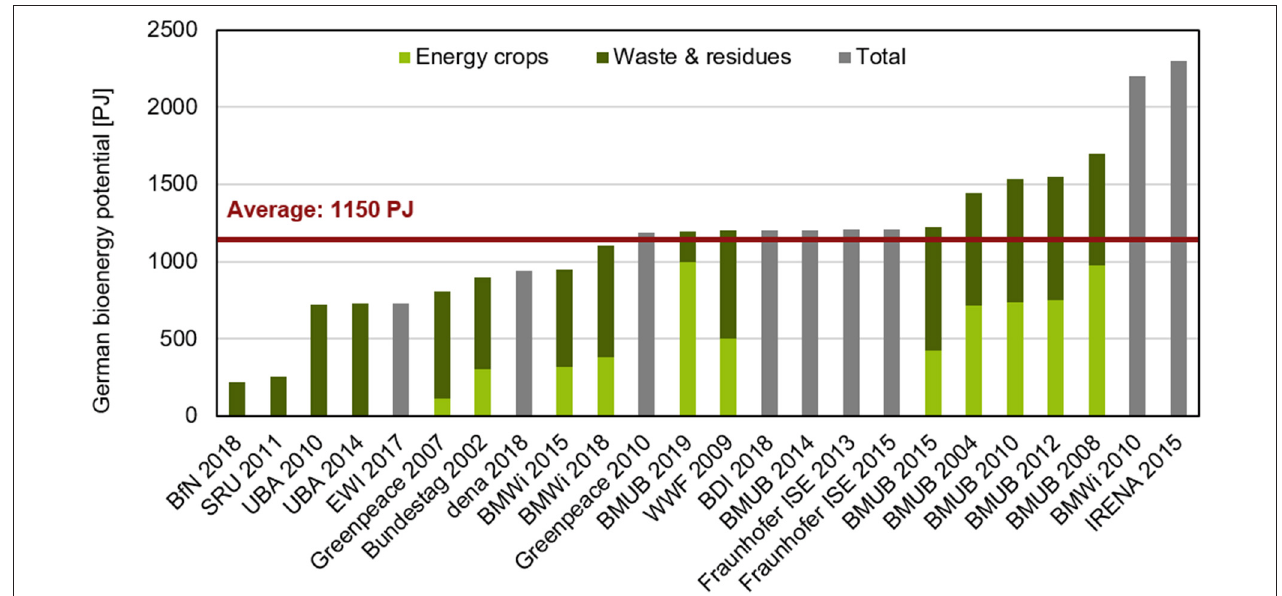
FIGURE 3 | Range of domestic bioenergy potentials as indicated by German scenario